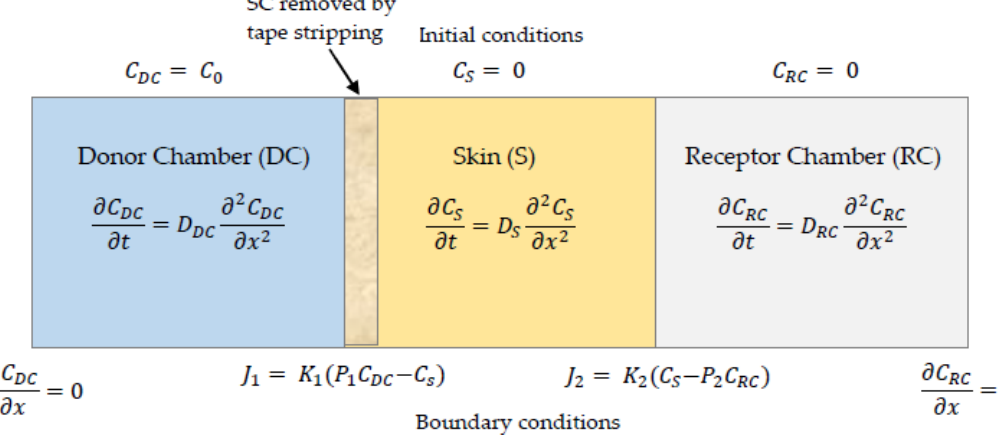
Figure 2. Schematic of the numerical model showing initial and boundary conditions. The mathematical model is solved numerically with the finite element method, in- corporating the boundary conditions. An implicit Euler method is used for the time integrations. For further details on the numerical model see Gudnason et al. [21].